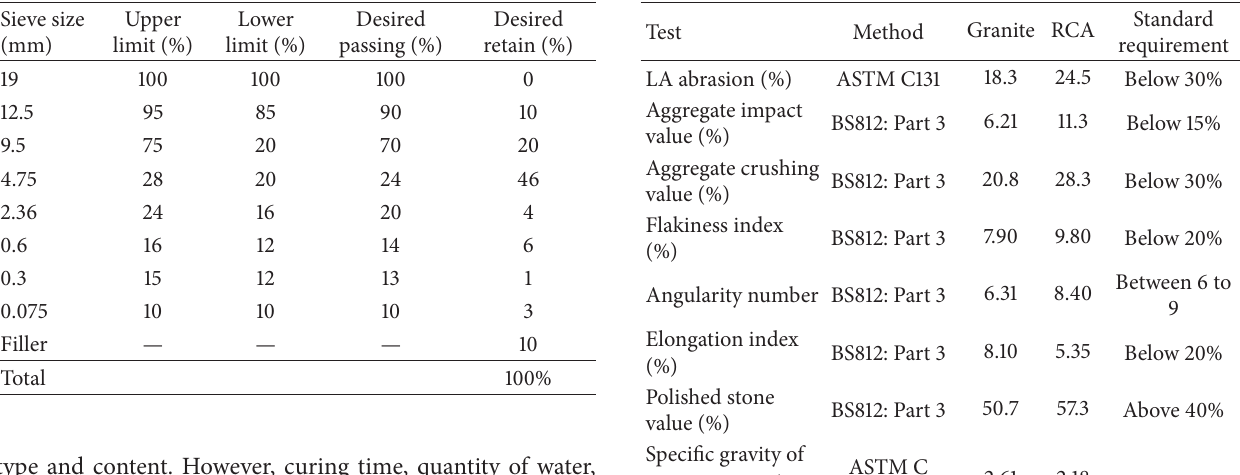
Table 1: Gradation used in this study (SMA 20). Table 2: Properties of aggregates.